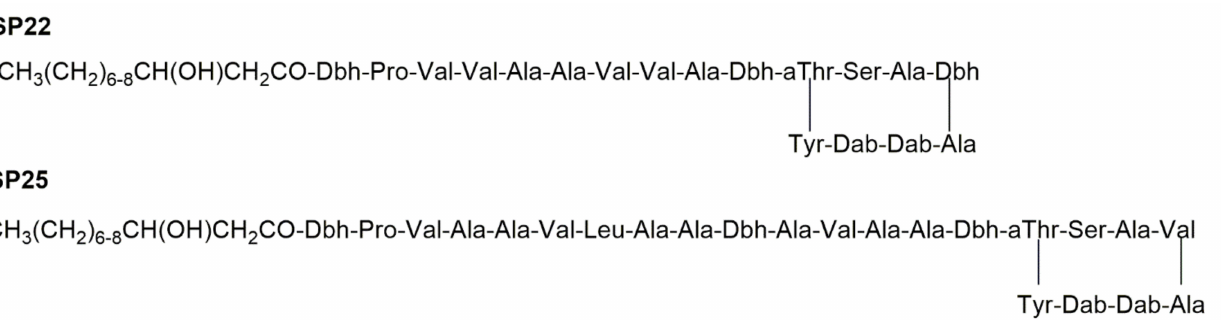
Figure 2. Structures of syringopeptin forms SP22 and SP25. The fatty acid can be either 3- hydroxydecanoic or 3-hydroxydodecanoic acid. Abbreviations of non-standard amino acids: Dab, 2,4-diaminobutyric acid; Dhb, 2,3-dehydroaminobutyric acid; a Thr, allothreonine. D-Amino acids are common in both SP22 (13 of 22 residues) and SP25 (15 of 25